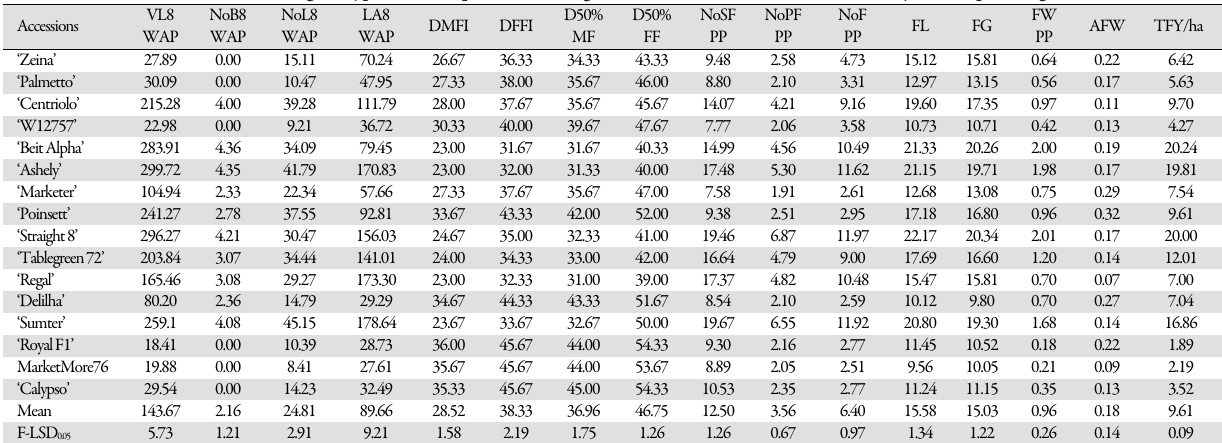
Table 3. Performance of cucumber genotypes with respect to some agronomic traits evaluated in 2014 early season planting VL8 Accessions WAP